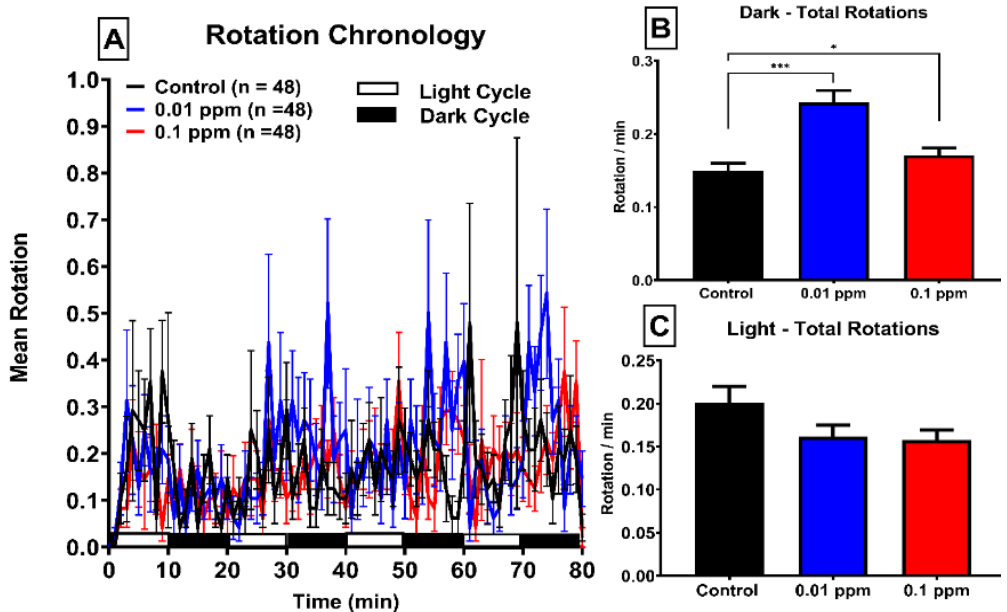
Figure 4. Rotation chronology of zebrafish larvae after exposure of Paclobutrazol. ( A ) Mean rotation in either light or dark phases of zebrafish larvae after treated with 0 (black color), 10 µg/L (0.01 ppm) (blue color) or 100 µg/L (0.1 ppm) (red color) ppm of Paclobutrazol. Quantitative comparison of rotation movement in the light phase ( B ) or dark phase ( C ) for zebrafish larvae after exposure of Paclobutrazol. The data are expressed as the means ± S.E.M. and analyzed by the one-way ANOVA with the Geisser–Greenhouse correction (* p < 0.05, *** p < 0.001).